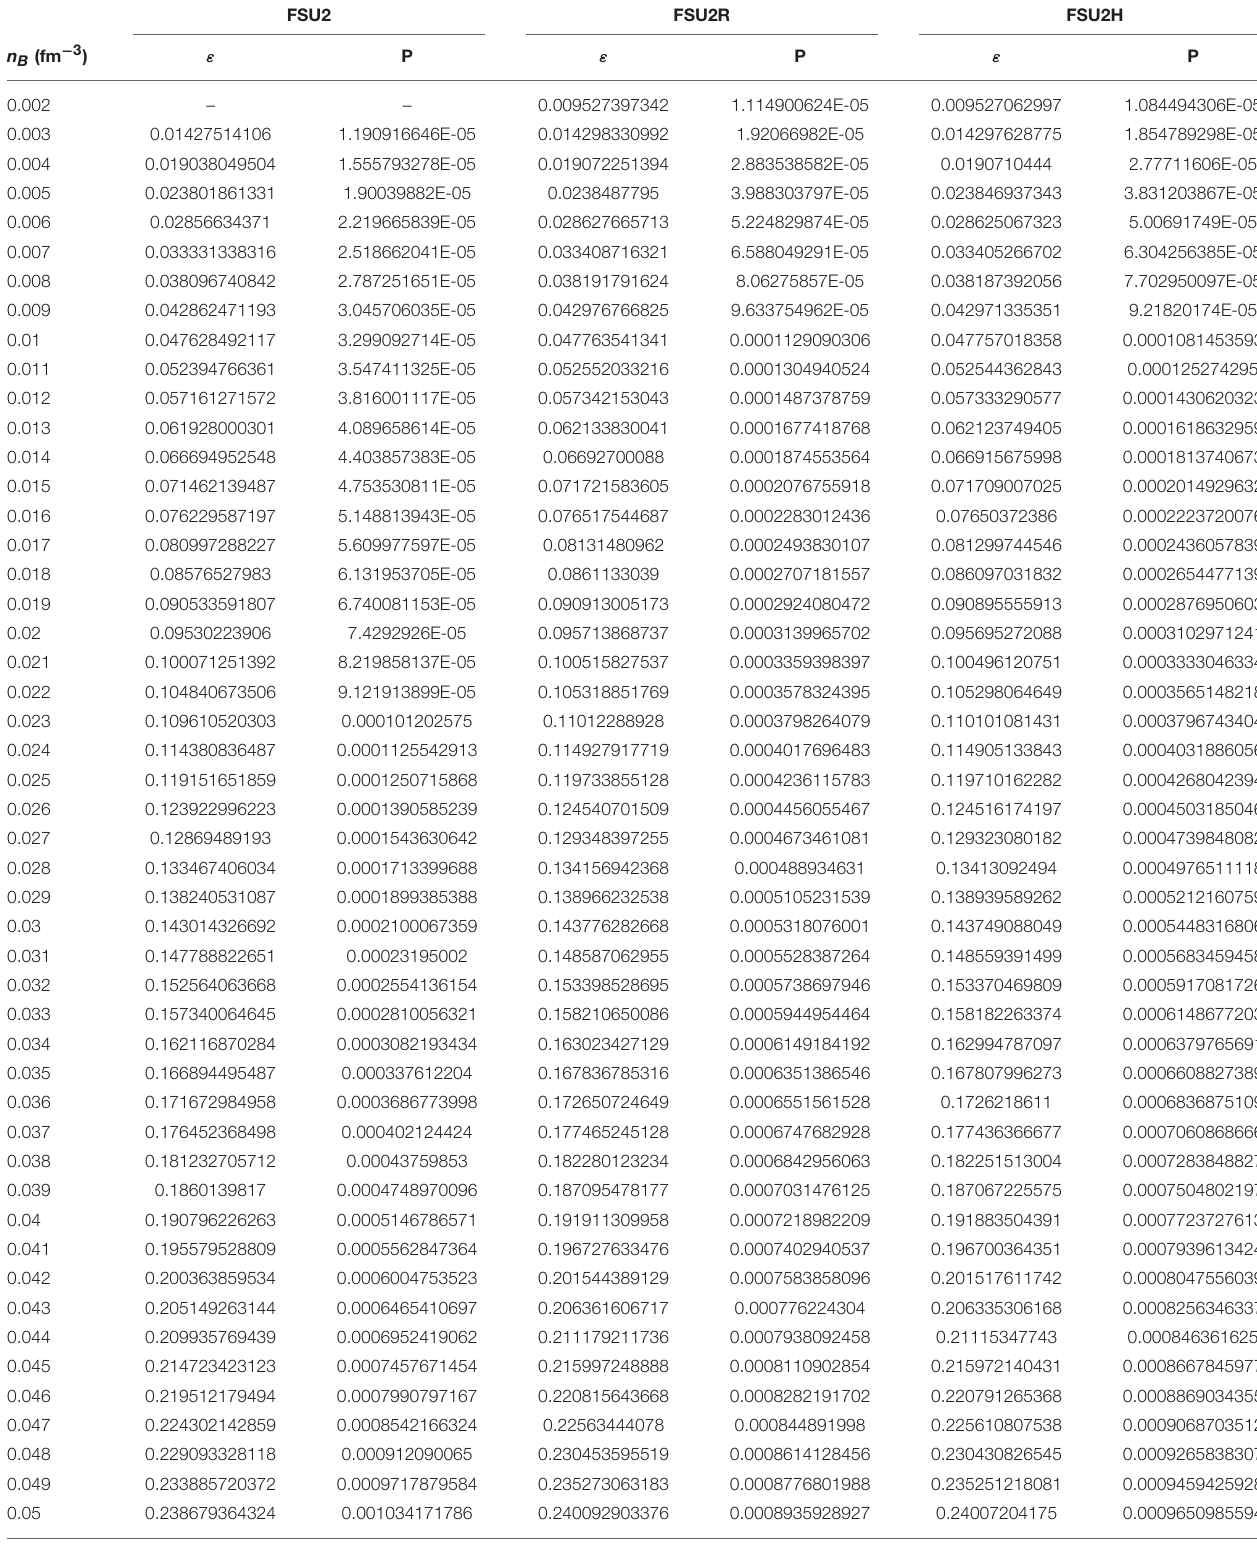
TABLE 5 | Equation of state of the inner crust with pasta for the FSU2, FSU2R, and FSU2H